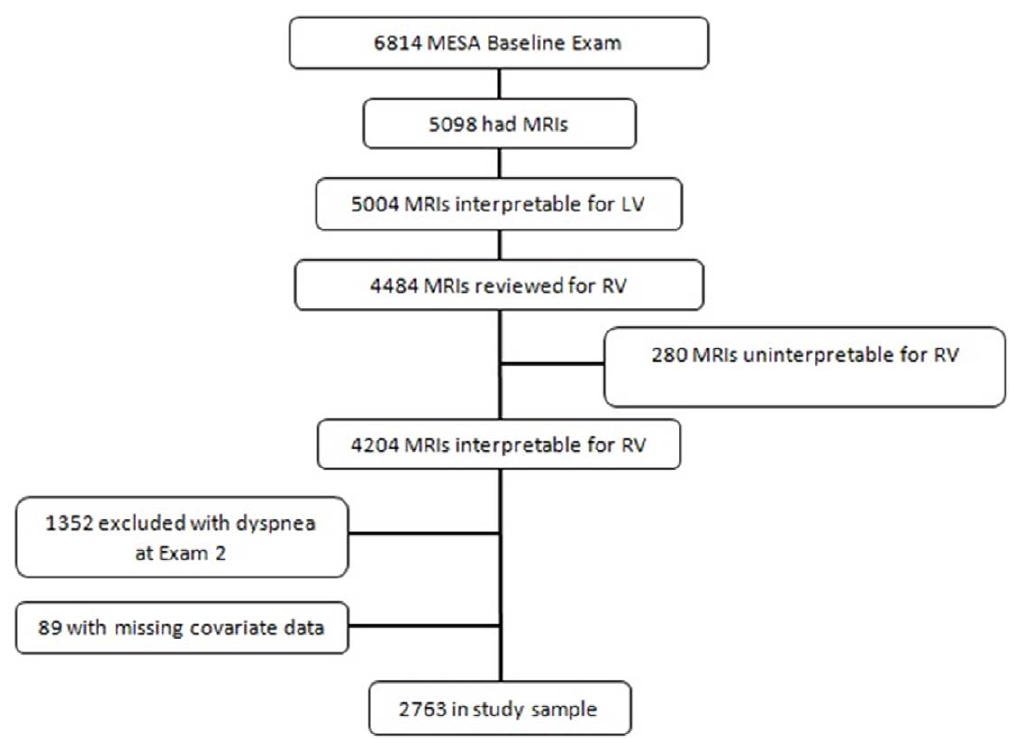
Figure 1. Study sample.